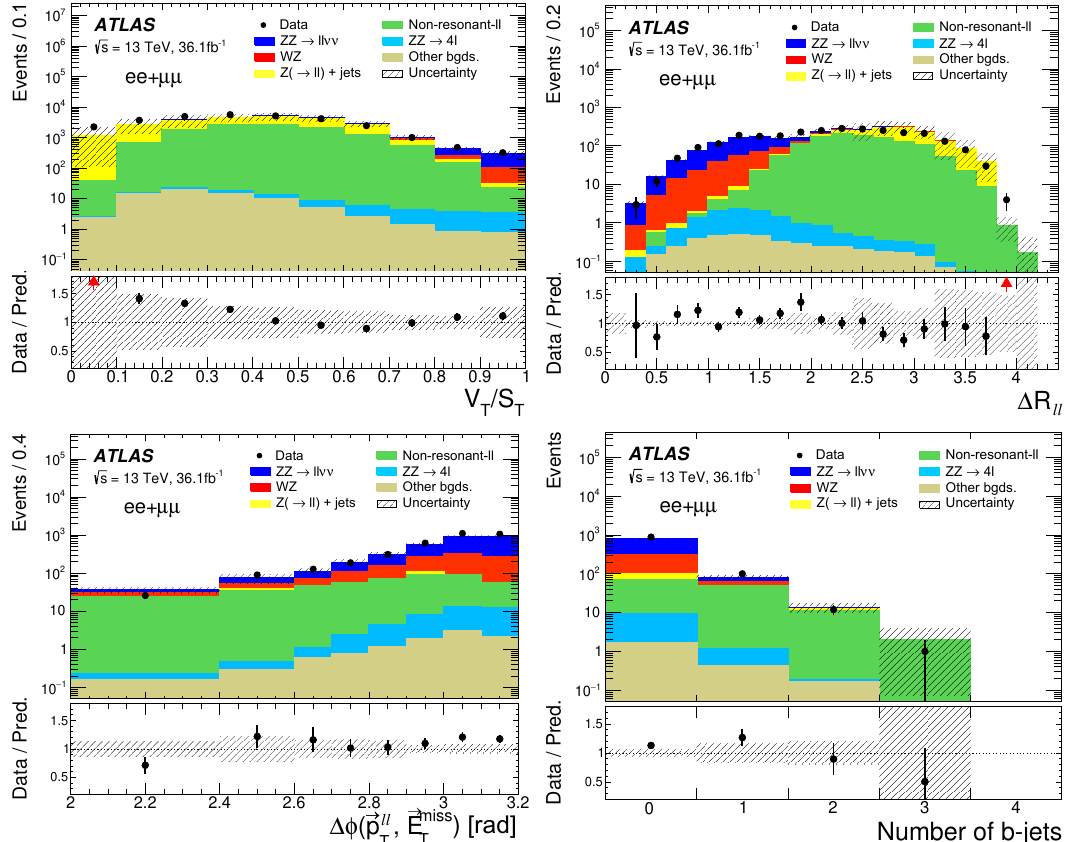
Figure 3 . The V =S , (cid:1) R , (cid:1) (cid:30) ( ~p ‘‘ ; ~E miss ), and the number of b -jets distributions for the T T ‘‘ T T combination of ee and (cid:22)(cid:22) channels with the implementation of all the cuts in table 2 prior to the cut on that variable. The expectation is derived from simulation and the hashed band accounts for the statistical and experimental uncertainties. The (cid:12)rst bin in the distribution of (cid:1) (cid:30) ( ~p ‘‘ ; ~E miss ) T T (bottom left) contains the under(cid:13)ow events. The arrow in the V =S distribution indicates that T T the di(cid:11)erence between the data and the expectation exceeds the y -axis scope of the bottom plot. The \other" background corresponds to the V V V and t (cid:22) tV